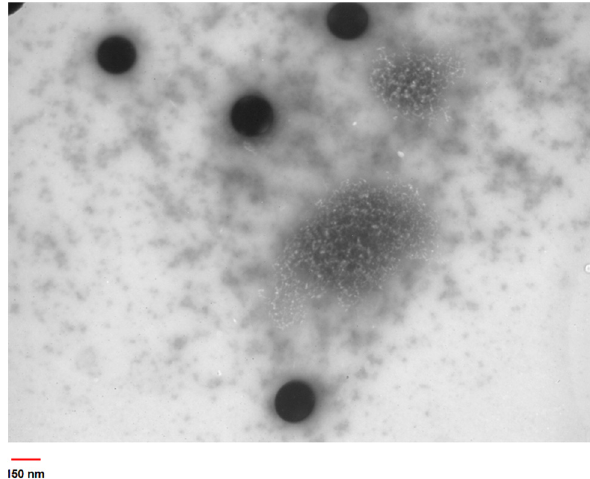
Figure 7: TEM image of the fabricated Se NPs using optimized synthesis